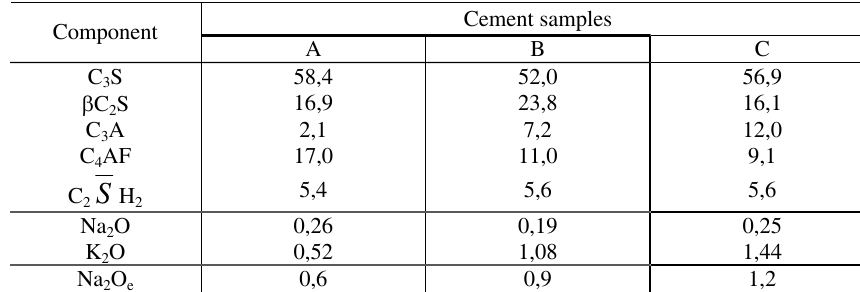
Table 2. Mineral composition of cements and contents of sodium and potassium oxides [%] Component